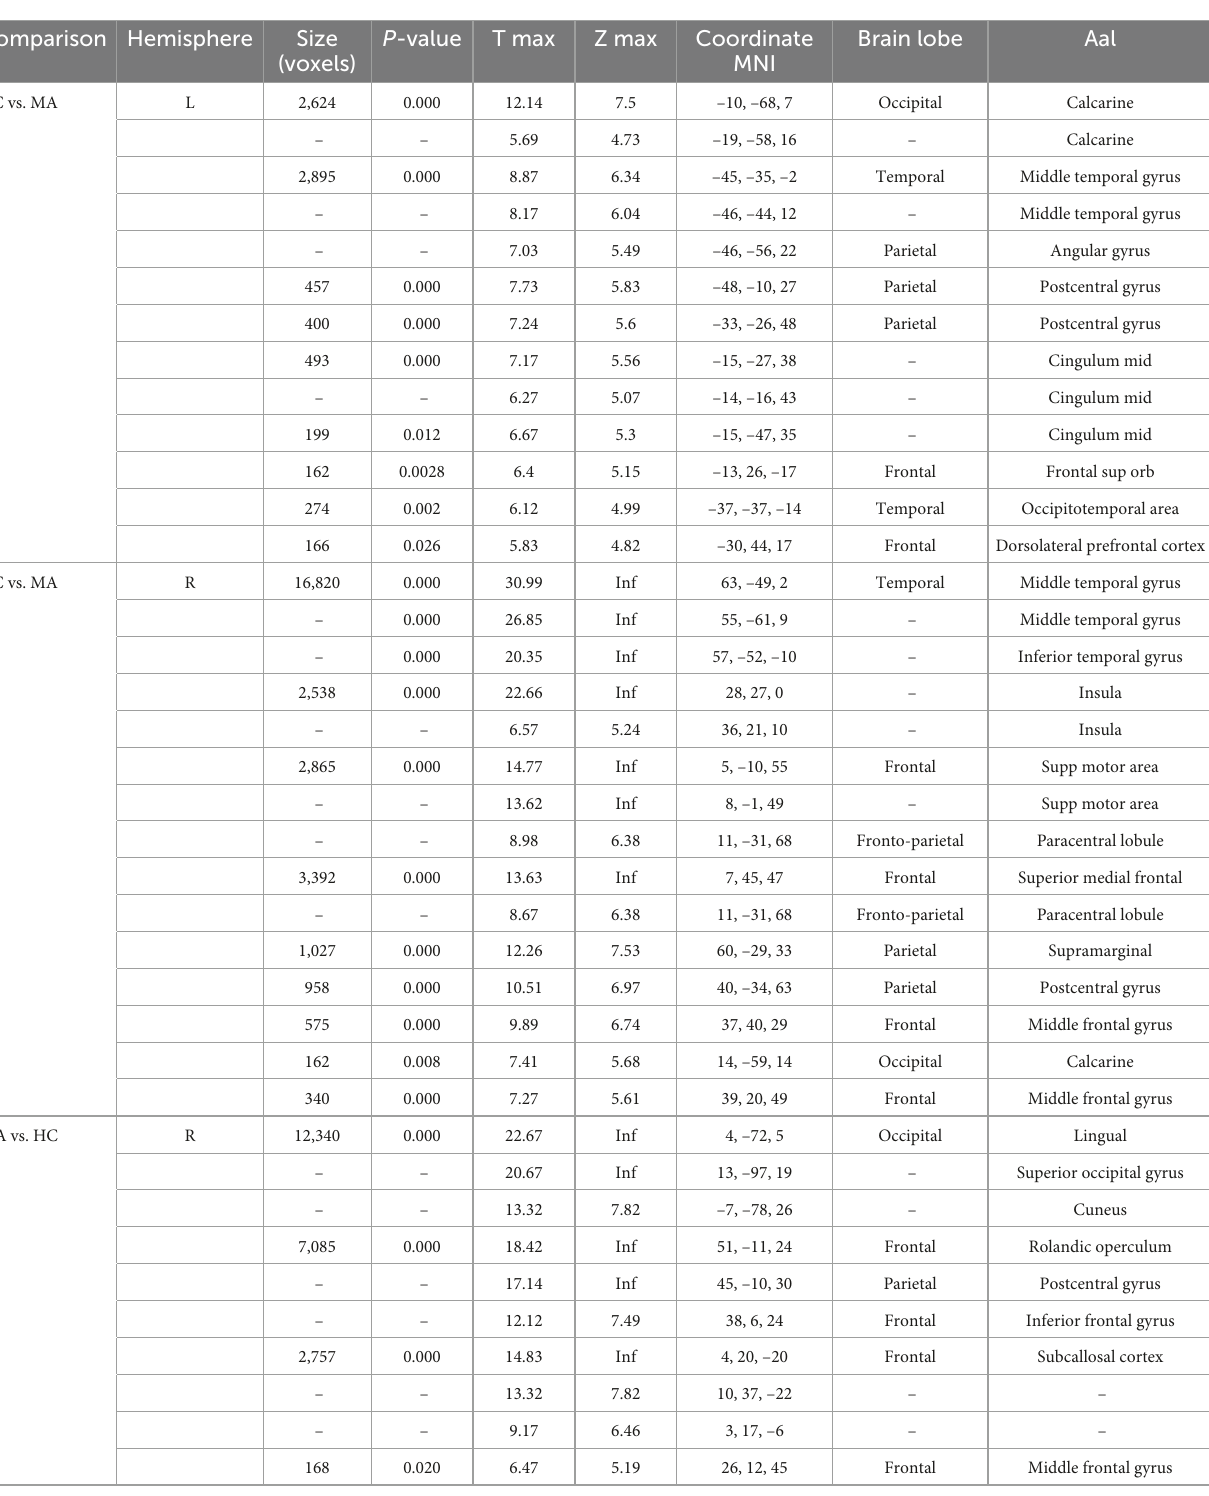
TABLE 2 Brain regions showing significant changes in thickness. Comparison